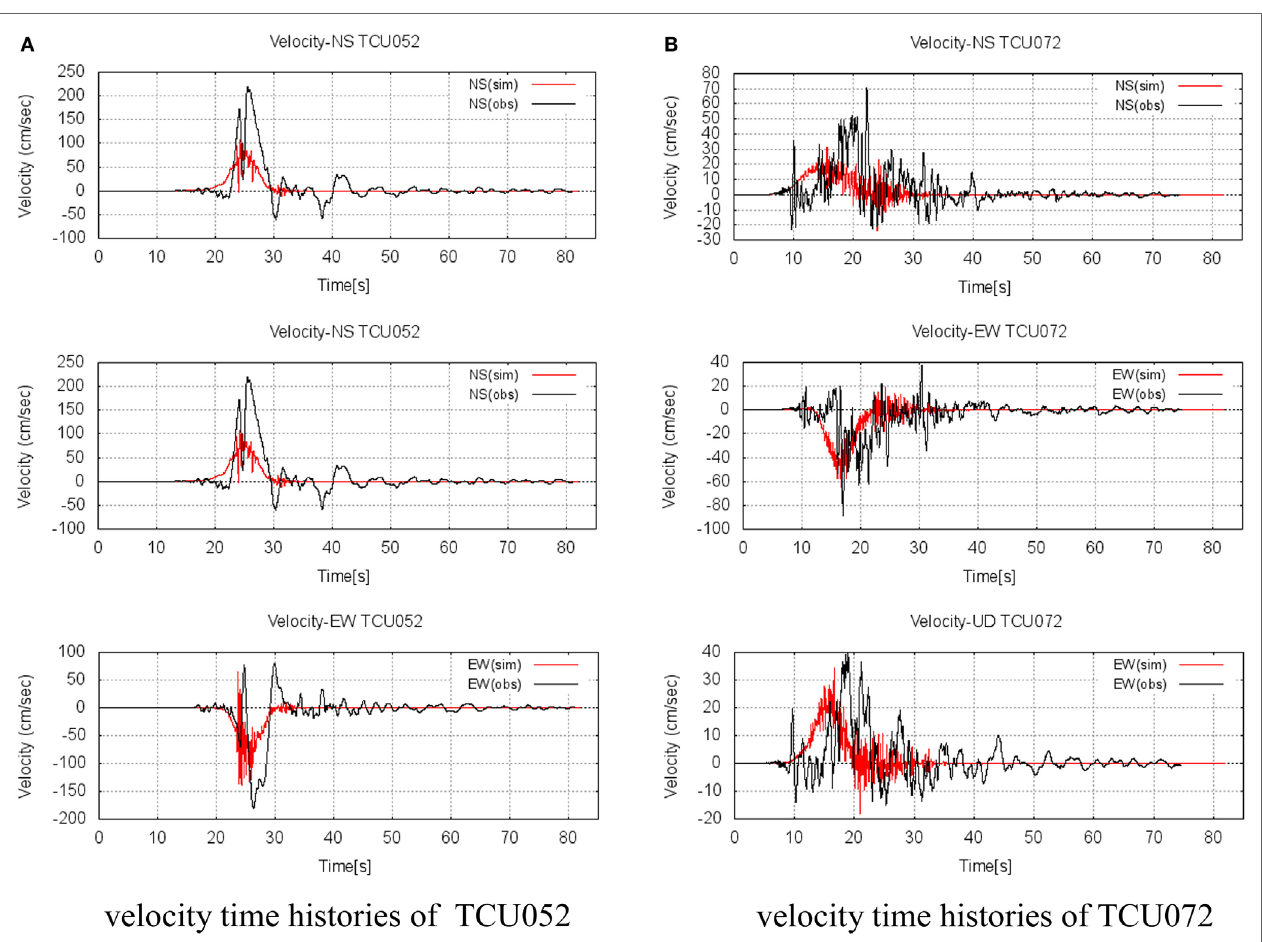
FigUre 13 | Observed (black line) and simulated (red line) waves for the velocity time histories, along the ns-, eW-, and UD-direction, respectively . (a) velocity time histories of TCU052 (B) velocity time histories of